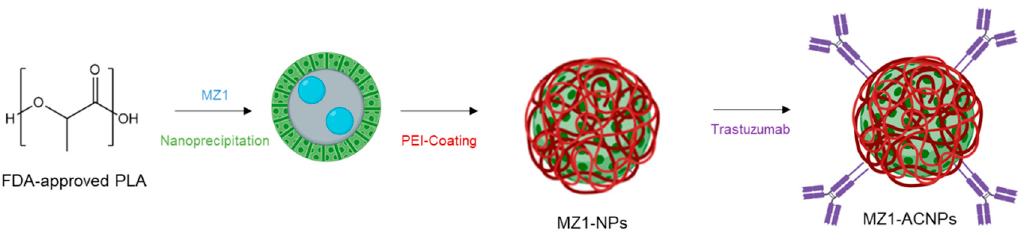
Scheme 1. Synthetic methodology for NPs design. Table 1. Average size, polydispersity index (PdI), and Z-potential of the different formulation obtained by dynamic light scattering (DLS).